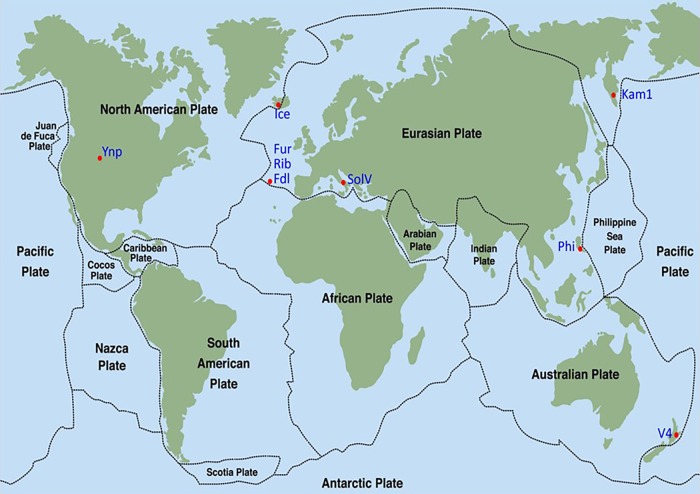
Sampling sites for isolation of thermoacidophilic methanotrophic Verrucomicrobia (indicated by red dots). Strain designations are indicated by blue color. Strippled lines indicate boundaries between tectonic plates.